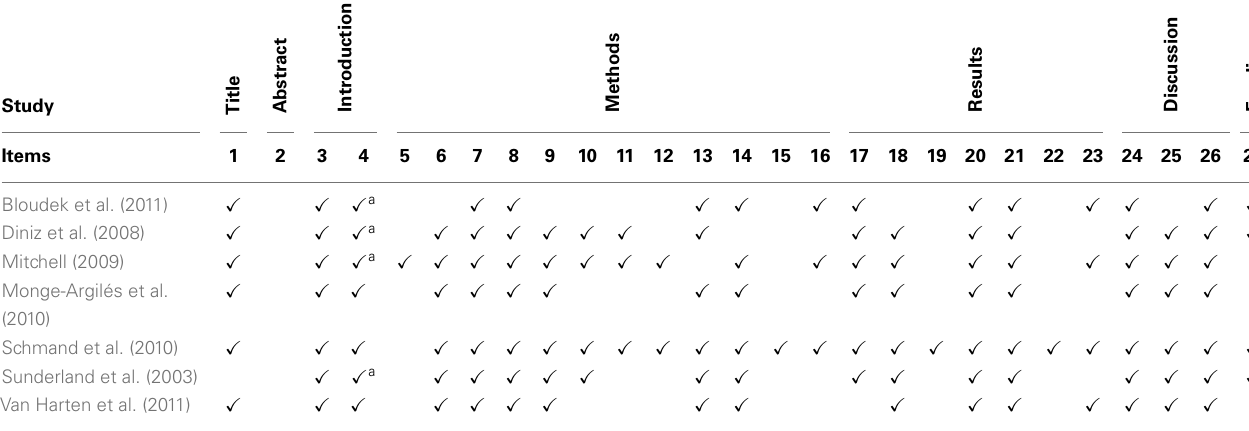
TableA5 | PRISMA checklist of items for reporting systematic reviews with